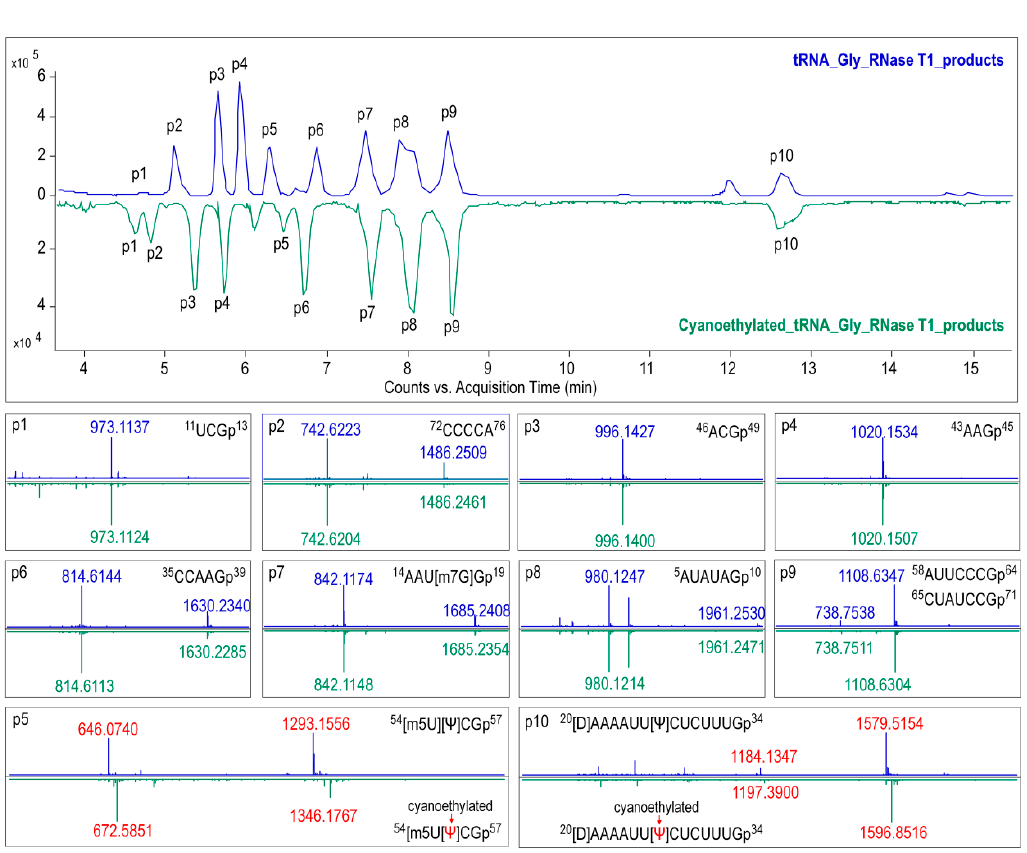
Figure 6. Baseline peak chromatograms (BPC) from LC-MS / MS analysis of RNase T1 digests of tRNA Gly(GCC) treated with (green) or without (blue) acrylonitrile. Mass spectra corresponding to each peak (p1 to p10) are extracted and displayed below the BPC. The red tag indicates the precursor ions with mass shift (of 53.027 for single charged ions) corresponding to the presence of cyanoethylated pseudouridine ( Ψ ) in the digestion products.